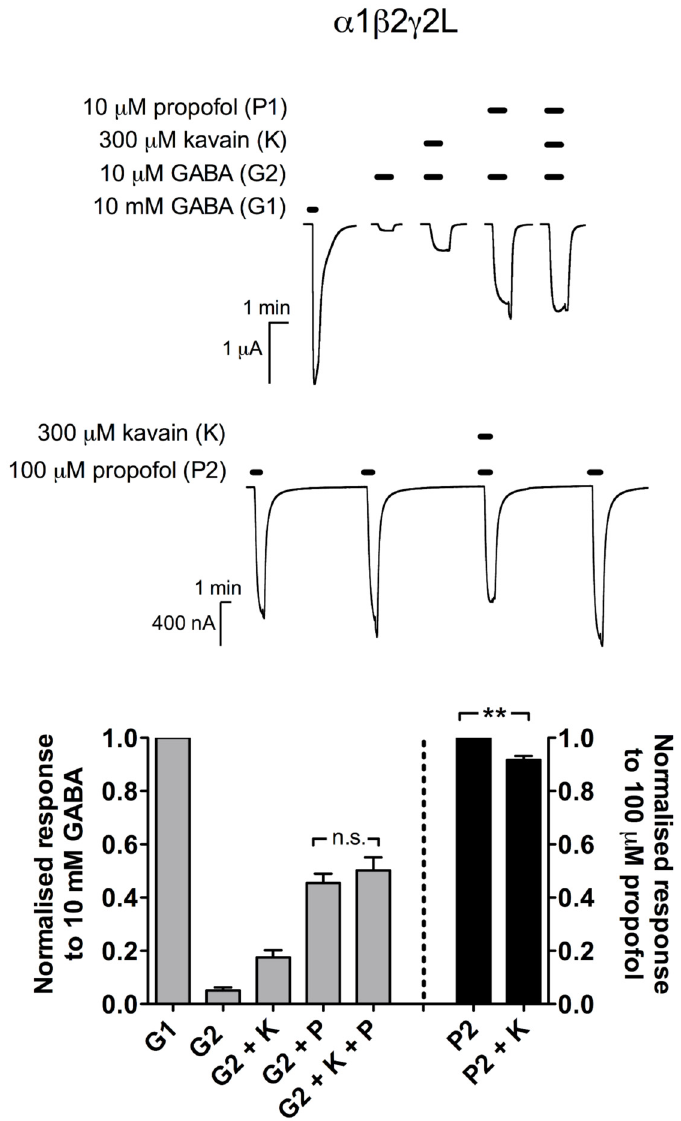
Fig 6. Kavain did not affect propofol potentiation, but modestly reduced propofol activation at α 1 β 2 γ 2L GABA A Rs. Top , Representative traces of current responses to 10 mM GABA (control); 10 GABA; 10 μ M GABA and 300 μ M kavain; 10 μ M GABA and 10 μ M propofol; 10 μ M GABA, 300 μ M kavain and 10 μ M propofol. Middle , Continuous traces demonstrating two consecutive applications of control (100 μ M propofol) followed by the co-application of 300 μ M kavain with control; and control. Bottom , Receptor modulation produced by propofol alone (G2 + P) was not significantly different from the combination of kavain and propofol (G2 + K + P; n = 5; p > 0.05; paired t test). The agonist effect of propofol (P2) was significantly reduced in the presence of kavain (P2 + K; n = 5; p < 0.01; paired t test). Data are presented as mean ±